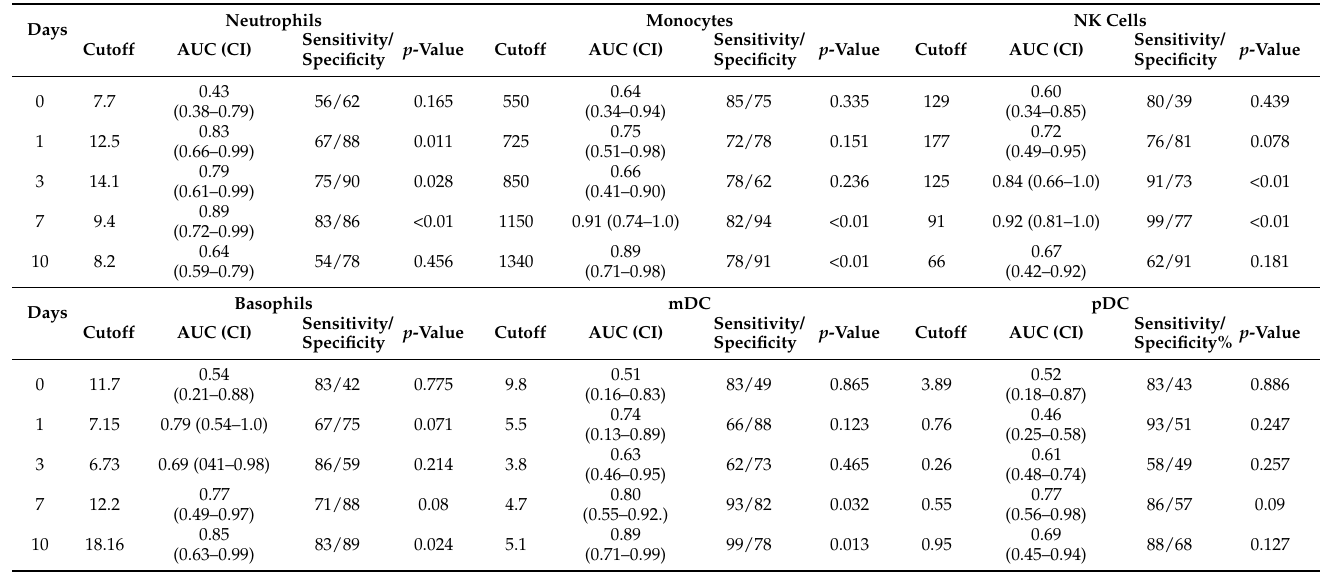
Table 3. ROC Analysis of different innate immunological markers on different pre- and postoperative